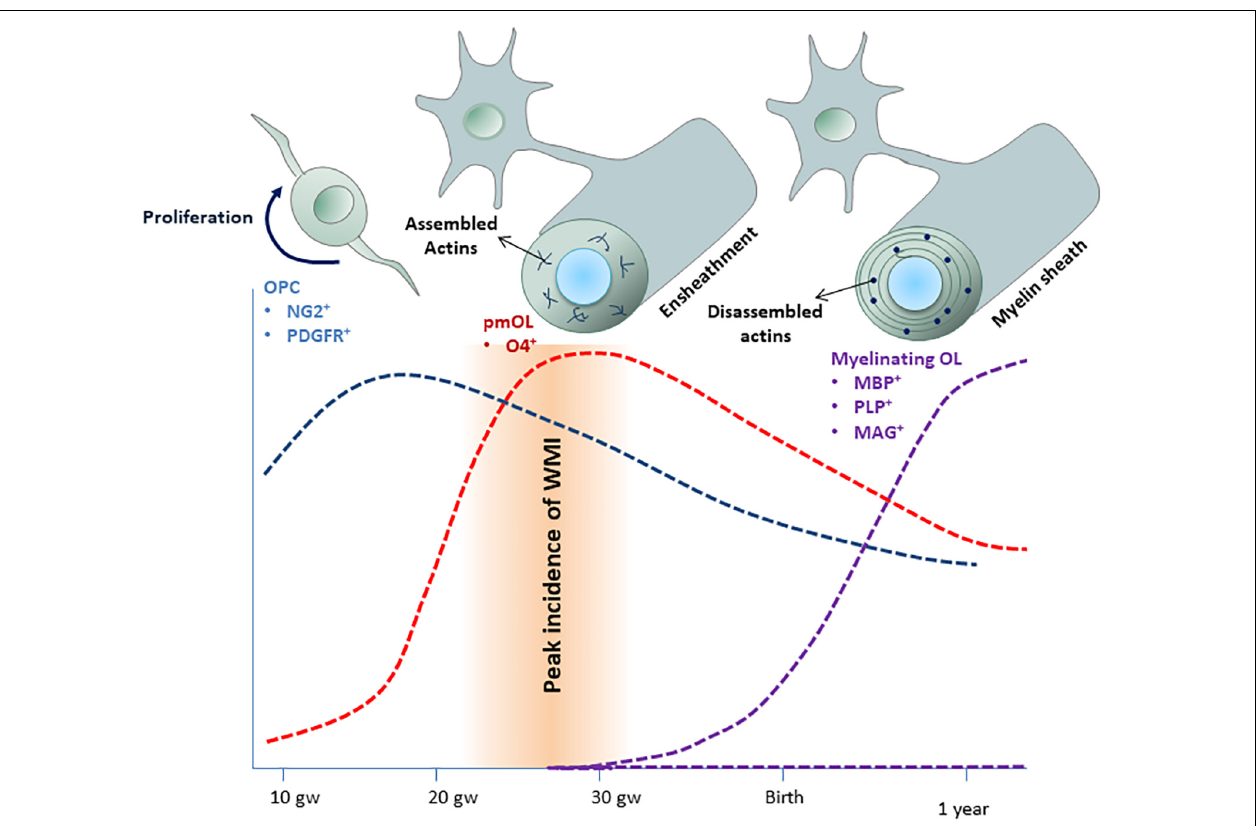
FIGURE 1 | Time-course o f human oligodendroglial cell development. Oligodendrocyte precursor cells (OPCs) appear around 9 gw and expanded between 15 and 20 gw (blue area). pmOLs appear as early as 18 gw but peak between 20 and 30 gw (red area). Myelination starts around 25 gw but mostly occurs during the first year of life and continues for several decades (purple area). The incidence of WMI peaks at 23–32 gw, when pmOLs dominate the OL lineage cells population. Actin filament assembly is essential for ensheathment, whereas dynamic actin filament assembly-disassembly drives myelin sheath